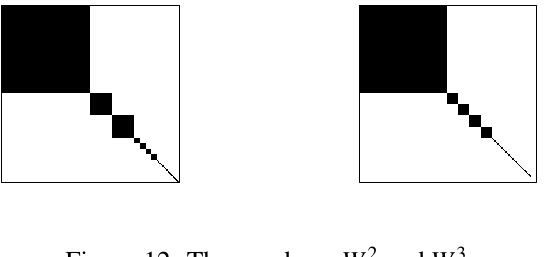
Figure 12: The graphons W 2